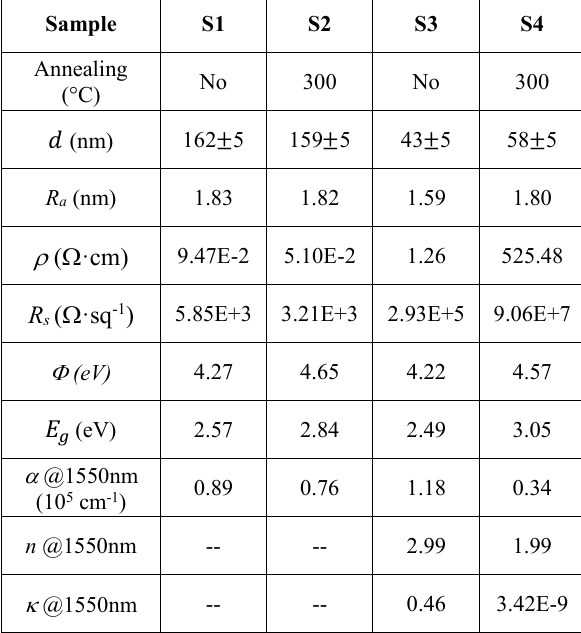
Table 1. Morphological, electrical, and optical properties of samples S1-S4.